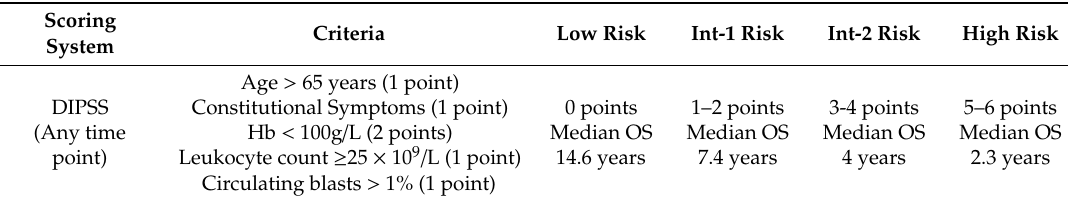
Table 3. Dynamic International prognostic scoring system (DIPSS) adapted from [11], which is widely used for enrolment in clinical trials; Int,